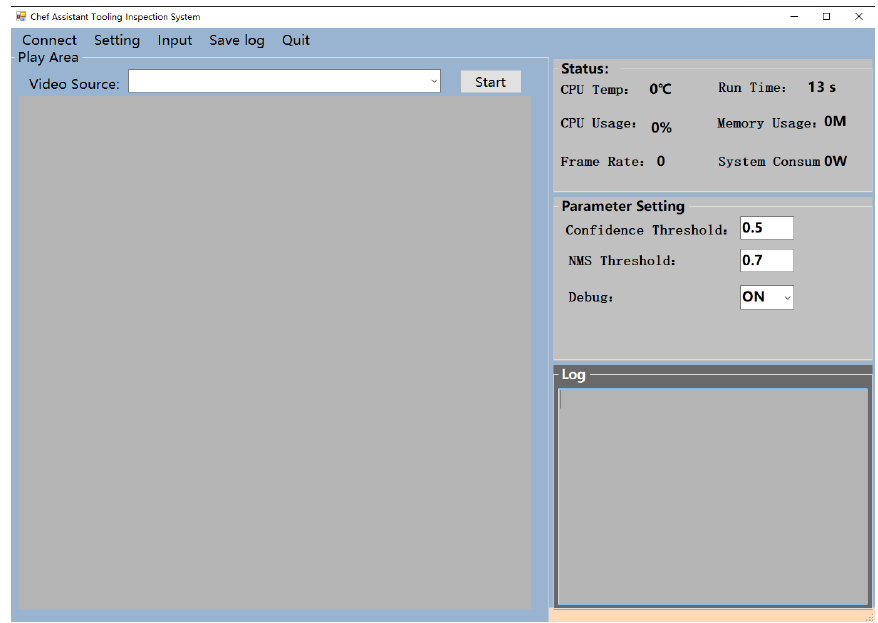
Figure 3. Interface of console software.